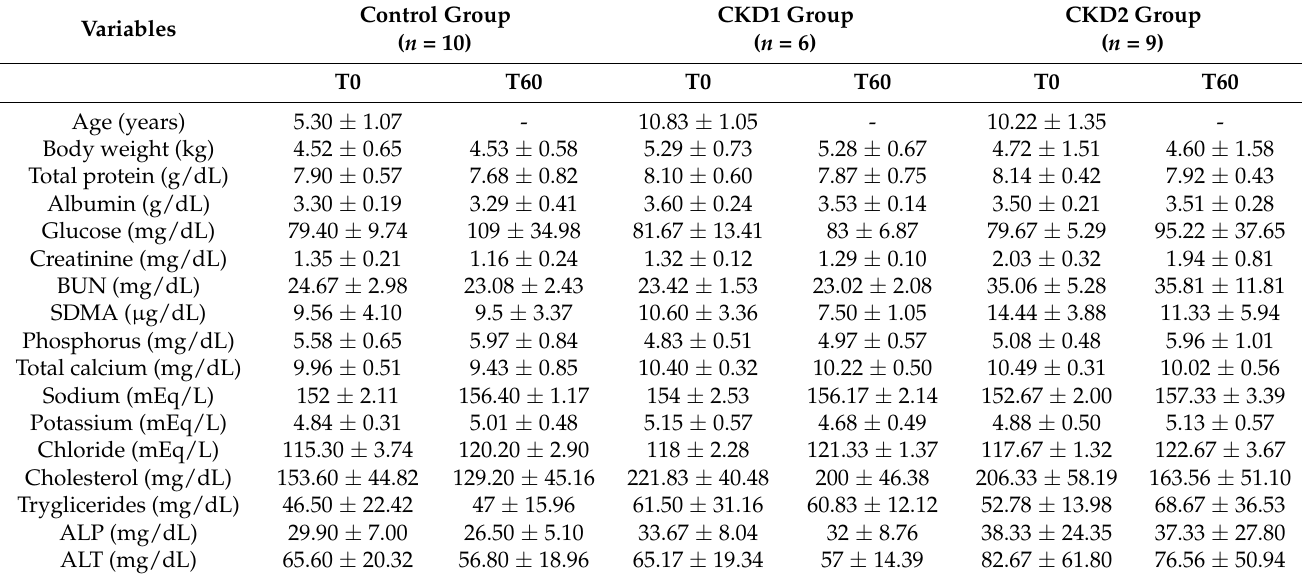
Table 2. Description of age, body weight and biochemical serum profile at T0 and